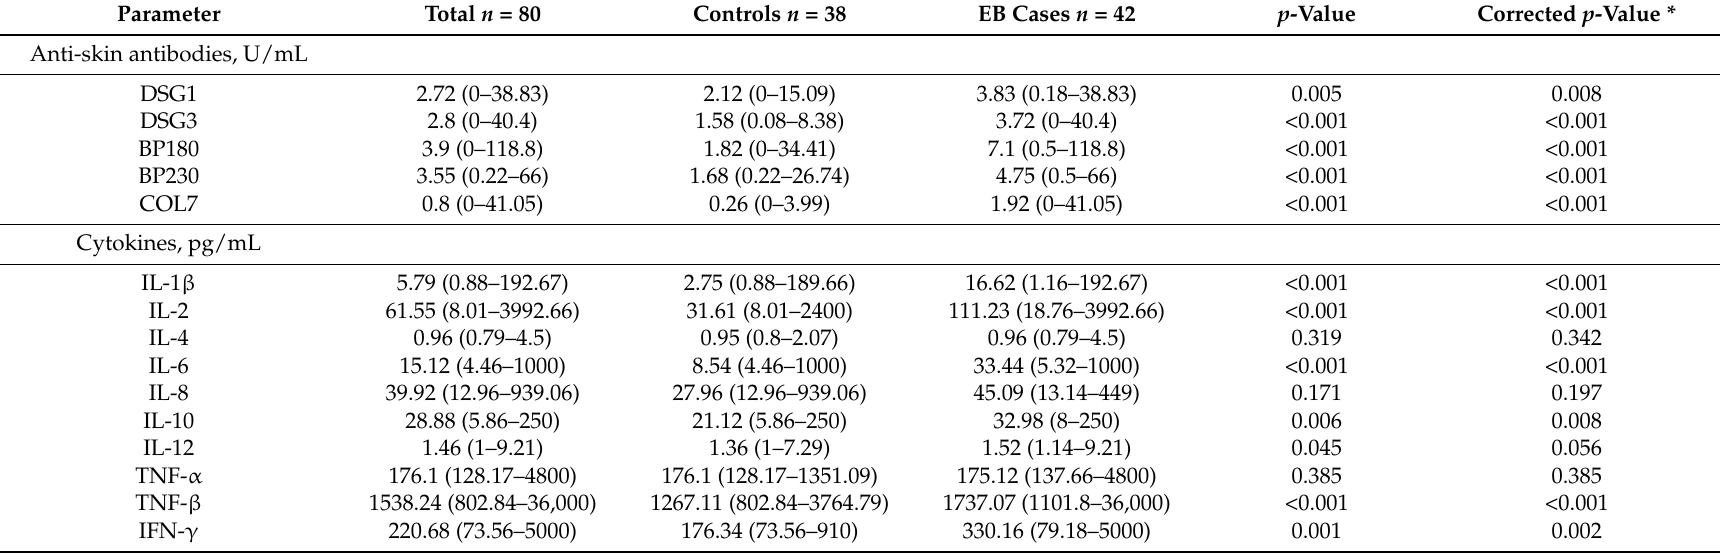
BP180: antibodies against bullous pemphigoid 180; BP230: antibodies against bullous pemphigoid 230; COL7: type VII collagen; DSG1: antibodies against desmoglein 1; DSG3: antibodies against desmoglein 3; EB: inherited epidermolysis bullosa; IFN: interferon; IL: interleukin; TNF: tumor necrosis factor. Median values (range in parentheses). * p -Values were adjusted for multiple testing using the false discovery rate method (with the Benjamini-Hochberg